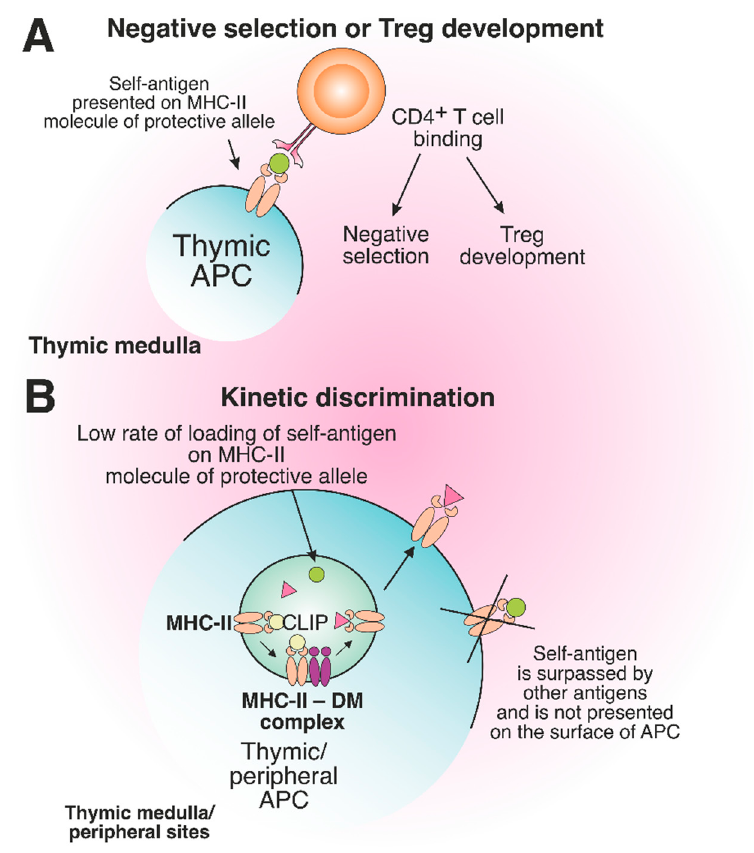
Figure 7. The role of protective MHC-II molecules in the suppression of autoreactive T cell development. ( A ) Recognition of the self-antigen presented on the product of the protective allele by CD4 + T cell results in negative selection or Treg development in the thymus. ( B ) The slow loading rate of self-antigen on the MHC-II molecule of the protective allele results in the failure of pMHC complex assembly on the surface of thymic or peripheral APCs.